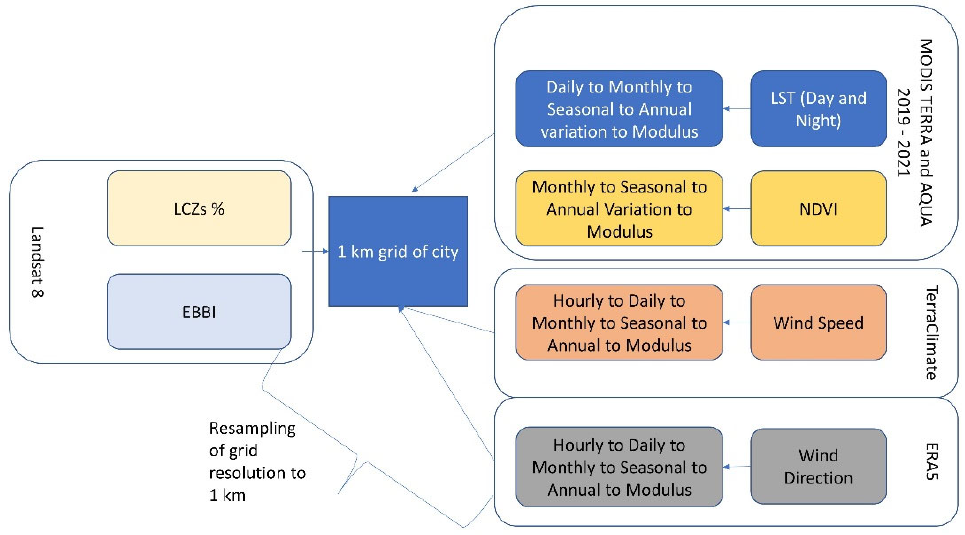
Figure 2. Deriving modulus for each of the datasets (Step 1).